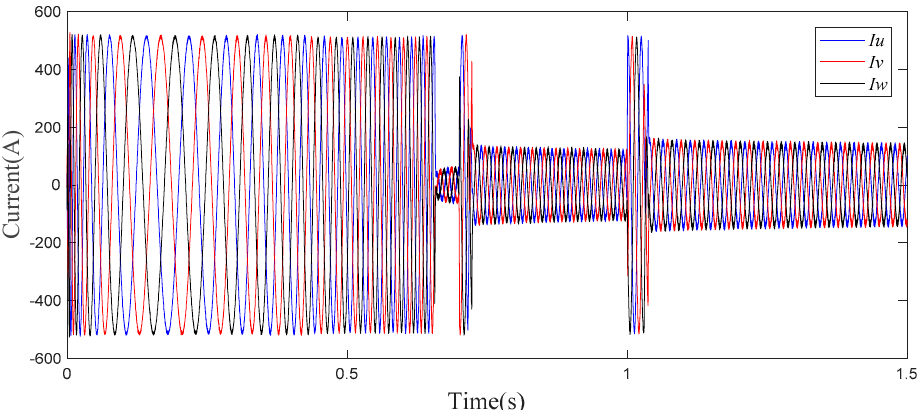
Figure 11. Step signal stator current.